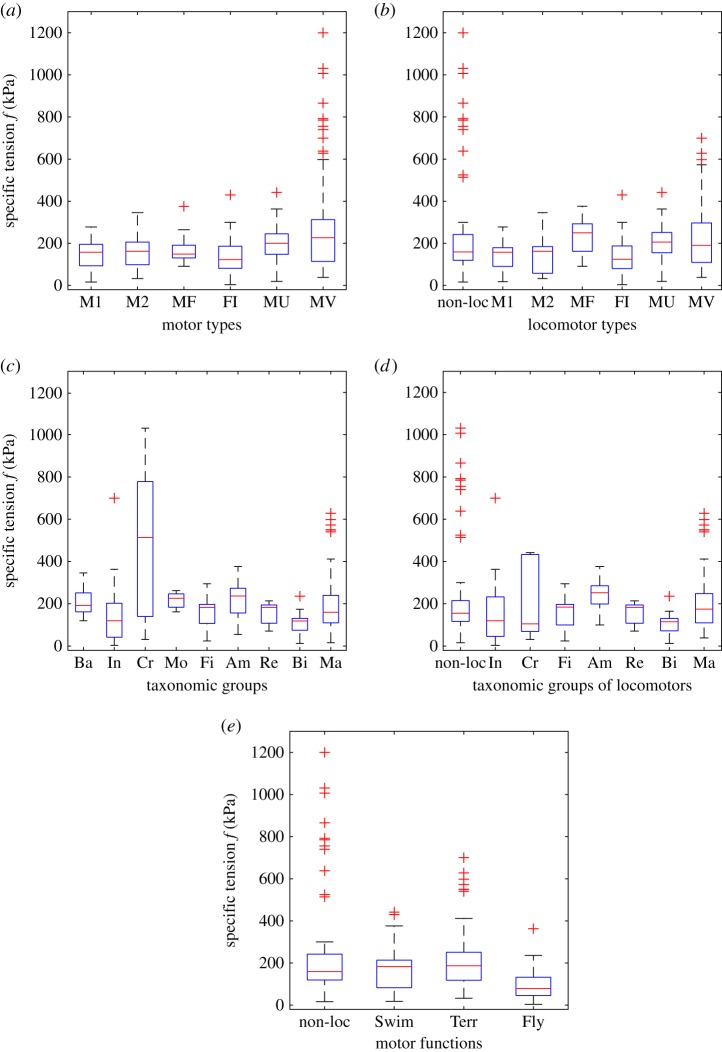
Boxplots of specific tensions of all motors except pili (n = 343). Pili were excluded from molecular assemblies (M2), bacteria (Ba) and terrestrial motors (Terr). (a) Per motor type. Abbreviations and number of values per class as defined in figure 2, except M1, single molecule (n = 27) and M2, molecular assembly (n = 9). ANOVA and multiple comparison of means (electronic supplementary material, table S2): MV ≠ (M1, FI, MU). Among the 11 MV outliers, 9 are claw muscles and 2 are jump muscles. (b) Same as (a) with non-locomotors (non-loc, n = 55) as a separate class. ANOVA and multiple comparison of means (electronic supplementary material, table S3): non-loc ≠ (M1, FI) and FI ≠ MV. (c) Taxonomic groups: Ba, bacteria (n = 7); Pr, protozoa (4); Al, algae (1); Fu, fungi (1); Ec, echinoderms (1); Ar, arachnids (1); In, insects (19); Cr, crustaceans (19); Mo, molluscs (5); Fi, fish (29); Am, amphibian (31); Re, reptiles (5); Bi, birds (18); Ma, mammals (202). Groups with n < 5 (protozoa, algae, fungi, echinoderms, arachnids) were removed (remaining data: n = 335); ANOVA and multiple comparison of means (electronic supplementary material, table S4): crustaceans are significantly different from all other groups. (d) Same as (c) for locomotors (n = 275) with non-locomotors (n = 48) as a separate class. Groups with n < 5 were removed (same as in (c), plus bacteria and molluscs). Insects (n = 17), crustaceans (5), fishes (28), amphibians (25), reptiles (5), birds (17), mammals (178). ANOVA and multiple comparison of means (electronic supplementary material, table S5): non-loc ≠ (Fi, Bi, Ma). (e) Per motor function: non-locomotory (n = 55), swimming (53), flying (25), terrestrial (210). Abbreviations and number of values per class as given in figure 1d, except for Terr (n = 210). ANOVA and multiple comparison of means (electronic supplementary material, table S6): non-loc ≠ (Swim, Terr, Fly) and Fly ≠ Terr.